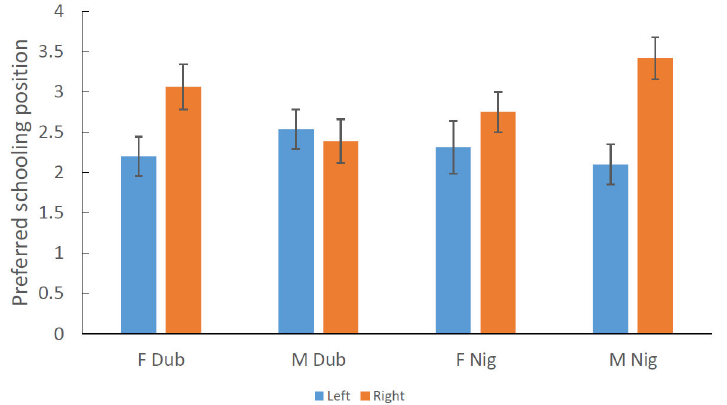
Figure 4. The mean (±SE) preferred schooling position for left and right lateralized M. duboulayi and M. nigrans . F = female, M = male. Scores > 2.5 represent a preference for the left side of the school. doi: